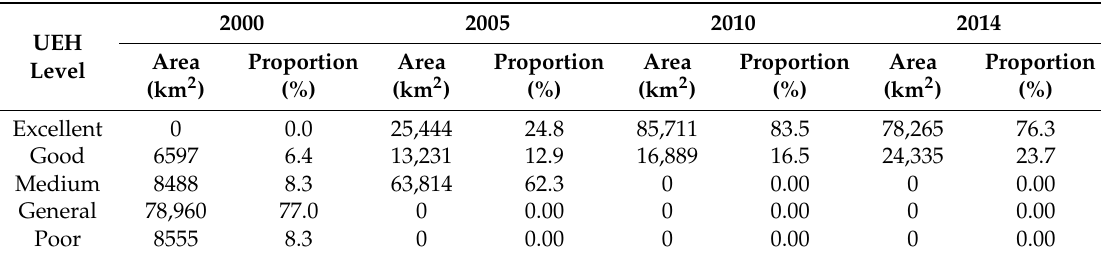
Table 6. The health level and area statistics of UEH in Jiangsu Province.